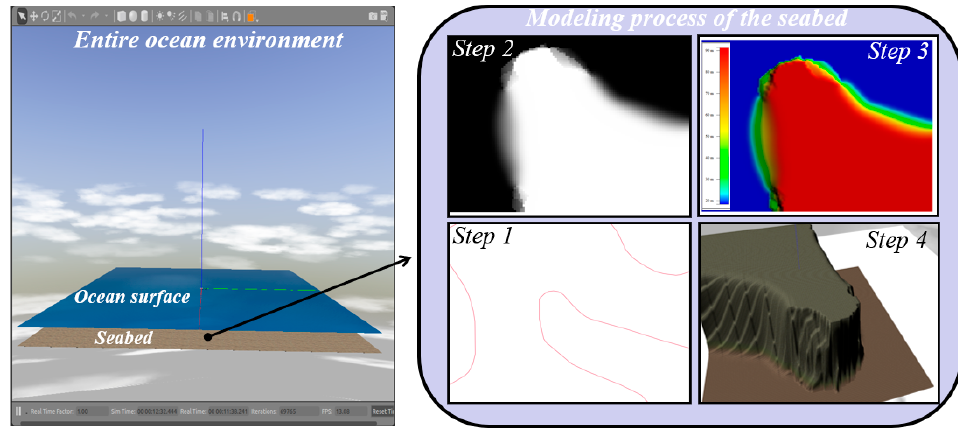
Figure 2. Visualization of the entire ocean environment and the modeling process of the seabed.